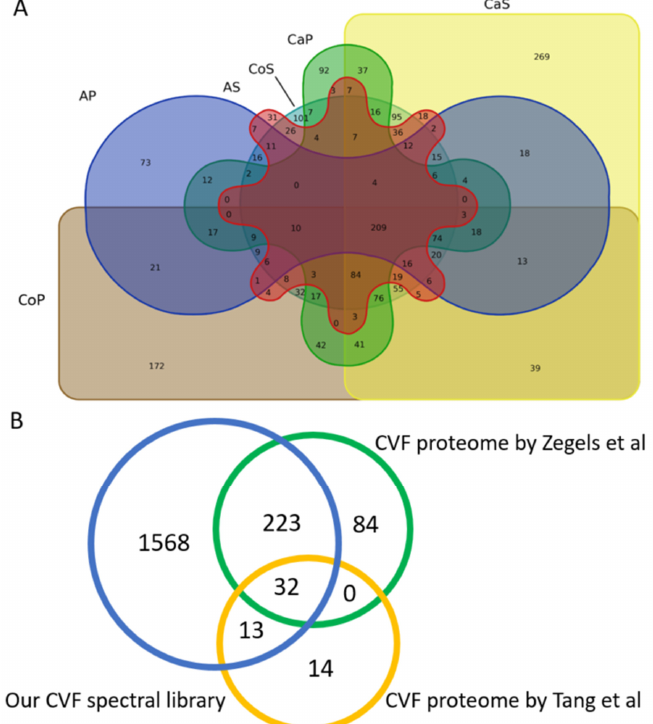
Figure 6. ( A ) Overview of the overlap of the various components that make up the consensus cervico ‐ vaginal fluid library. AP: Atypical hyperplasia cell pellets, AS: Atypical hyperplasia supernatant, CaS: Cancer supernatant, CaP: Cancer pellets, CoS: Control Supernatant, CoP: Control pellets. All analyses were conducted based on proteins identified by proteotypic peptides. ( B ) Overview of the overlap between the cervico ‐ vaginal fluid consensus spectral library and the cervico ‐ vaginal fluid proteome described by Zegels et al. and Tang et al. respectively. Next, we sought to compare the coverage of our cervico ‐ vaginal fluid spectral library with the cervico ‐ vaginal fluid proteome reported in previous studies. We did not identify any studies describing the cervico ‐ vaginal fluid proteome of post ‐ menopausal women with or at risk of endometrial cancer. A comparative overview of the various studies con ‐